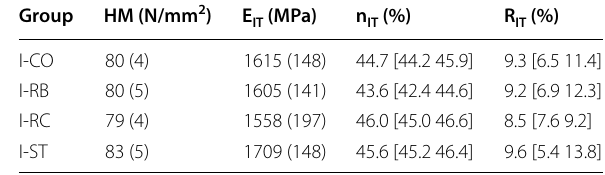
Mean values and standard deviations (in parentheses) or median and 25 and 75% percentiles (in brackets). No statistically significant differences were found between the immersion groups and the control for the properties tested ( p >